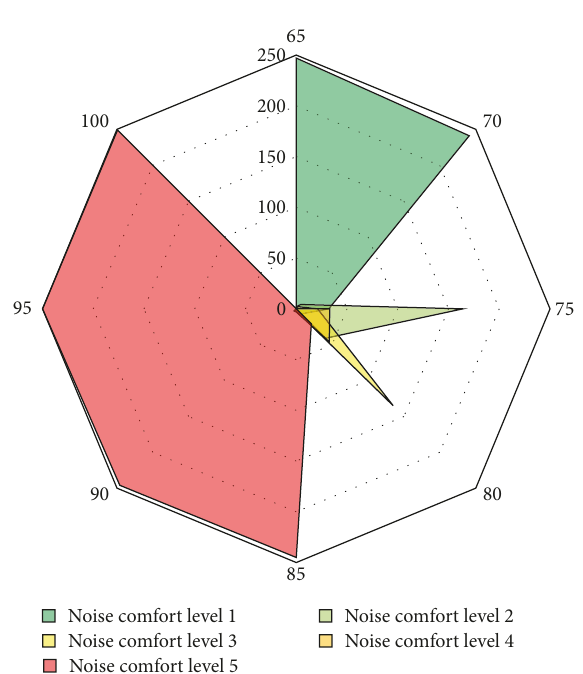
Figure 5: Preliminary sample survey results to detect the perceived noise